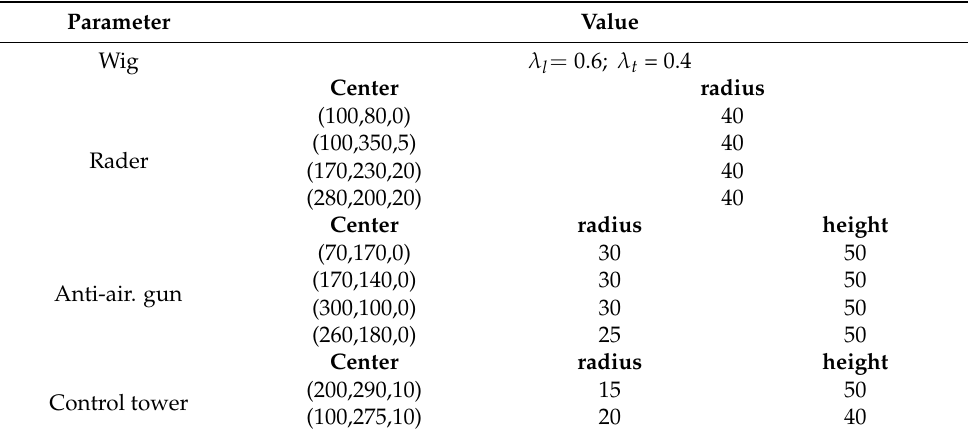
Table 3. Parameters that were adjusted in the